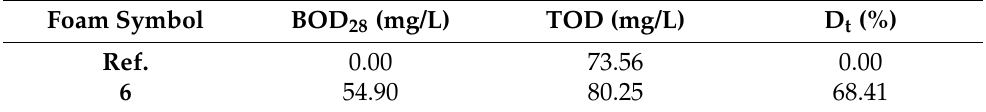
Table 9. Results of susceptibility to biodegradation of